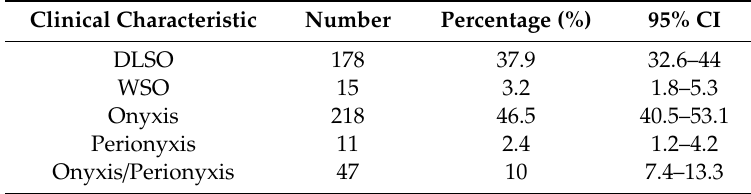
Table 2. Clinical aspect of the lesions ( n = 469).